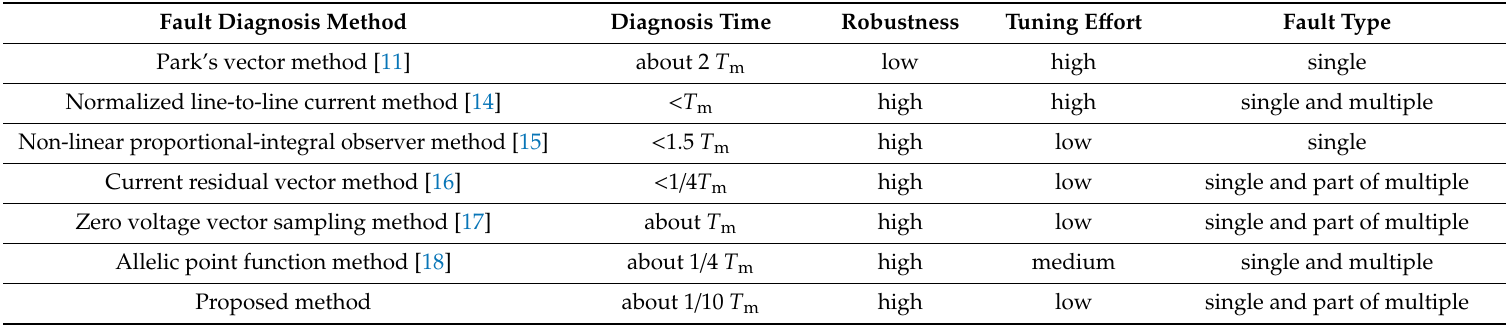
Table 7. Comparison of fault diagnoses between previous current-based methods and the proposed